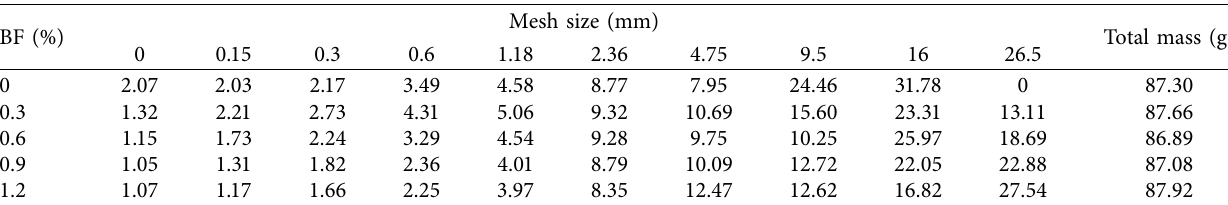
Table 5: Sieving test results of impact fragments of basalt fiber-reinforced cement-fly ash-stabilized soil (0.5MPa impact loading